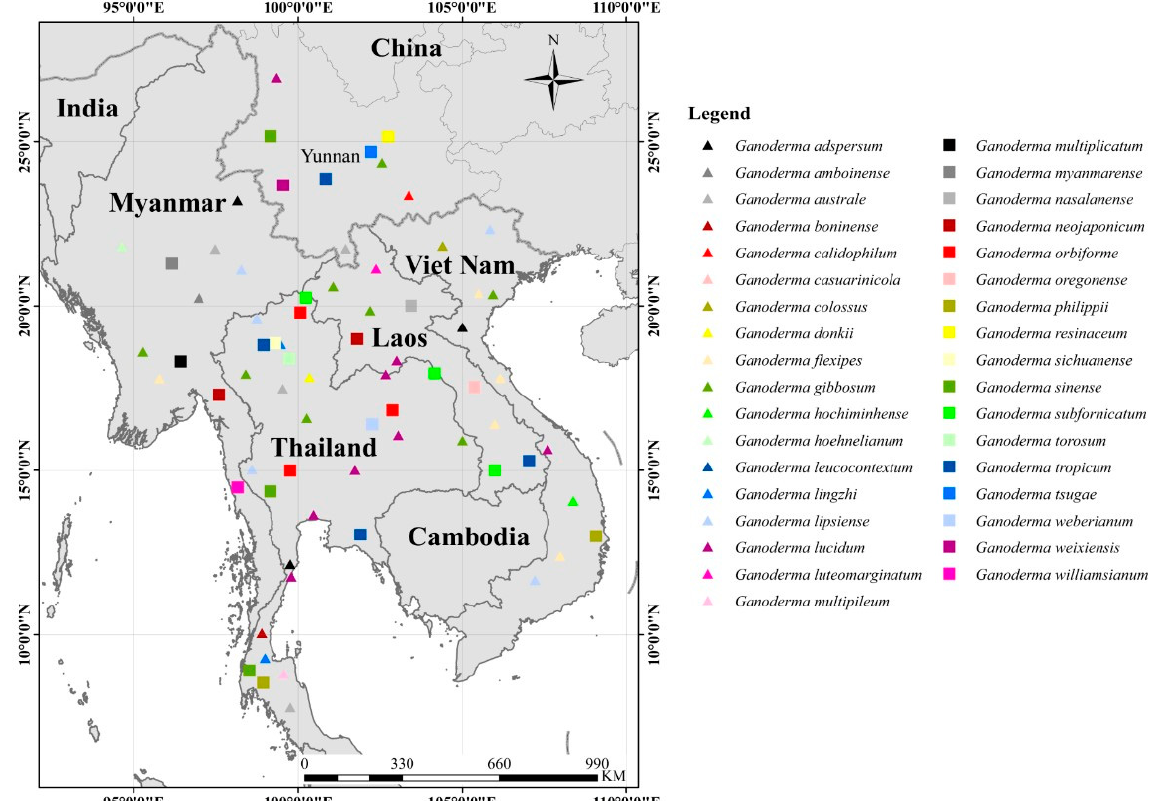
Figure 1. Distribution of Ganoderma species in the GMS.